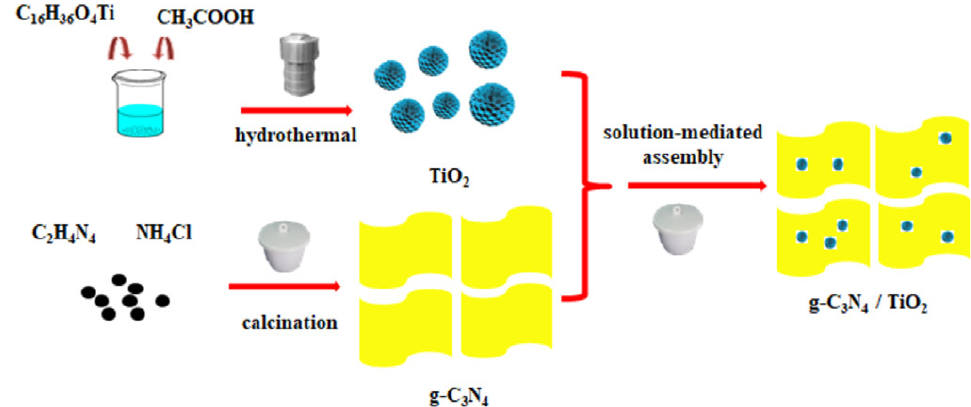
Figure 21. Schematic representation for the fabrication of 3D TiO 2 /2D g-C 3 N 4 composites. Copyrights 2019 Elsevier [176].